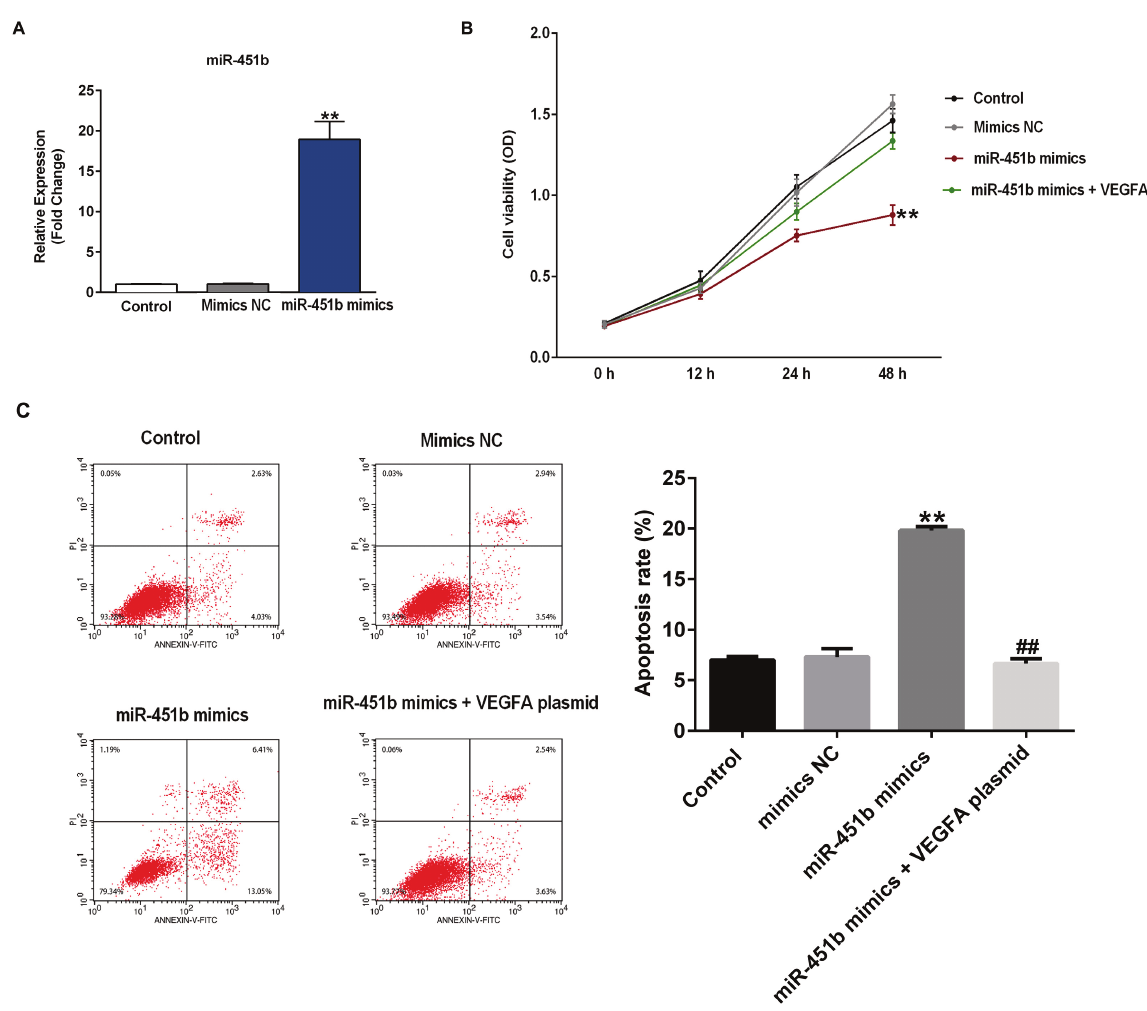
Figure 3. miR-451b inhibits cell proliferation and promotes cell apoptosis in HUVECs. (A) qRT-PCR assay detected the relative expression of miR-451b when HUVECs were transfected with miR-451b mimics or NC mimics for 48 h. (B) CCK-8 assays were carried out to determine cell viability when the HUVECs were transfected with miR-451b mimics, or miR-451b mimics+VEGFA plasmid for 48 h. (C) Flow cytometry analysis analyzed the percentage of apoptotic cells when HUVECs were transfected with miR-451b mimics, or miR-451b mimics+VEGFA plasmid for 48 h. The cell apoptosis rate was calculated and presented. **p<0.01 vs. mimics NC; ##p<0.01 vs. miR-451b